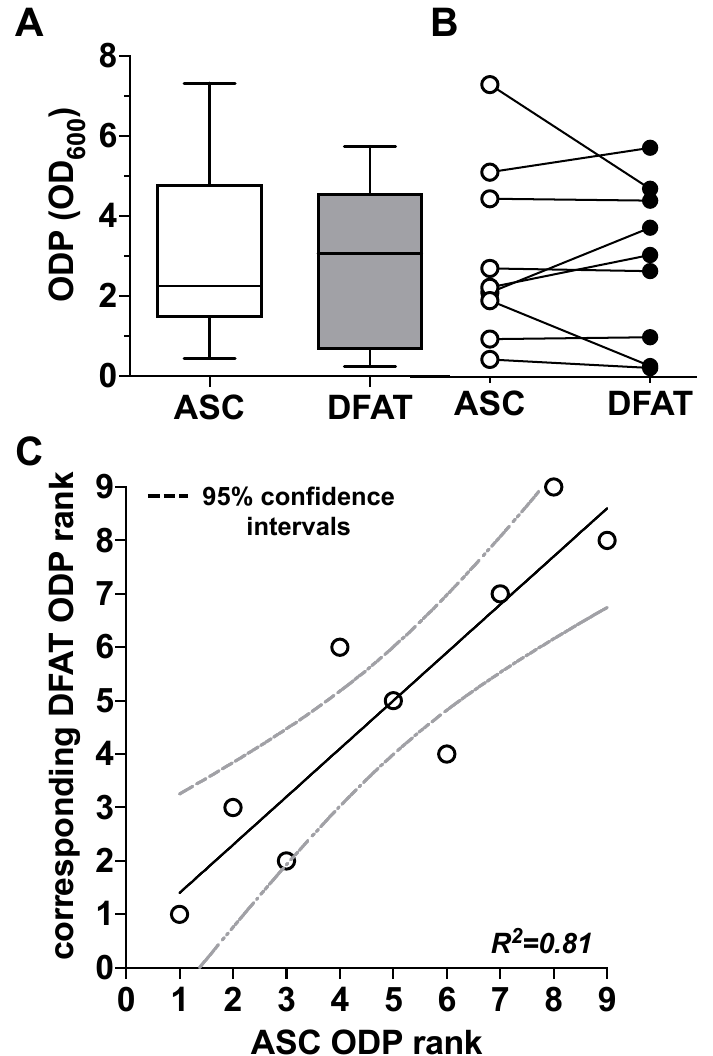
Figure 3. Comparison of the osteogenic differentiation potential (ODP) of ASC and DFAT cultures obtained from the same adipose tissue sample. ( A ) Quantitative evaluation of the osteogenic differentiation potential (ODP) of osteogenically activated ASC (white box) and DFAT cultures (grey box). The ODP values at day 14 of differentiation of 9 individual ( n = 9) ASC or DFAT cultures are shown as boxplot with median value and with whiskers with minimum and maximum. As measurement parameter of the respective ODP value we used of the optical density of the Alizarin Red redissolution at 600 nm (OD 600 ) of the cultures indicated. ( B ) Representation of the individual ODP values used in A of the ASC cultures examined (white circles) and of the corresponding DFAT cultures (black circles) which were produced from the same adipose tissue. ( C ) Rank analysis of the ODP values of the ASC cultures examined (X axis) and the corresponding ODP values of the DFAT cultures established from the same tissue (Y axis). The solid line represents the regression line (R 2 = 0.81), the dashed lines indicate the 95% confidence intervals. p < 0.0005, slope deviation from zero.